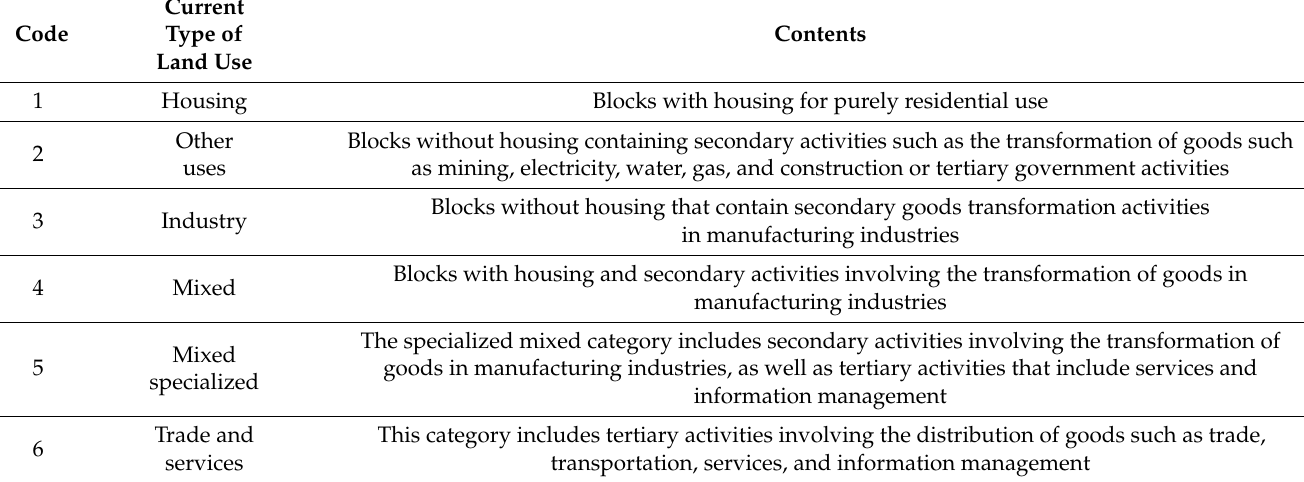
Table 3. Classification of Current Land Use according to INEGI